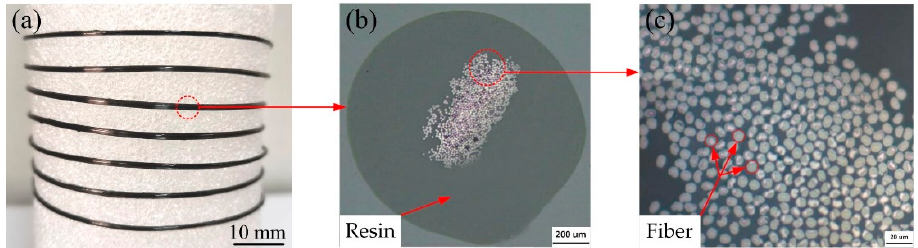
Figure 1. ( a ) Continuous carbon fiber reinforced resin matrix composite wire; ( b ) composite wire microstructure (cross section); ( c ) distribution of fibers in the resin.